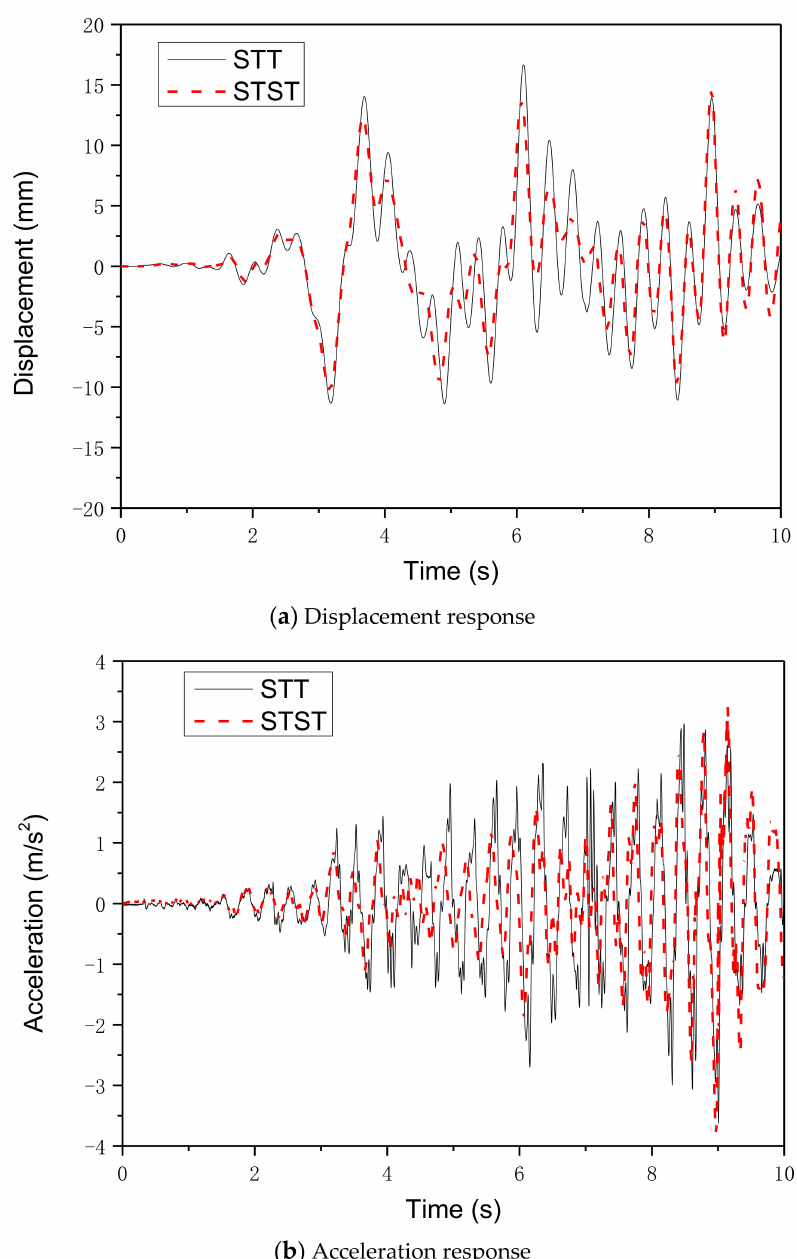
Figure 11. Experimental results with the Taft